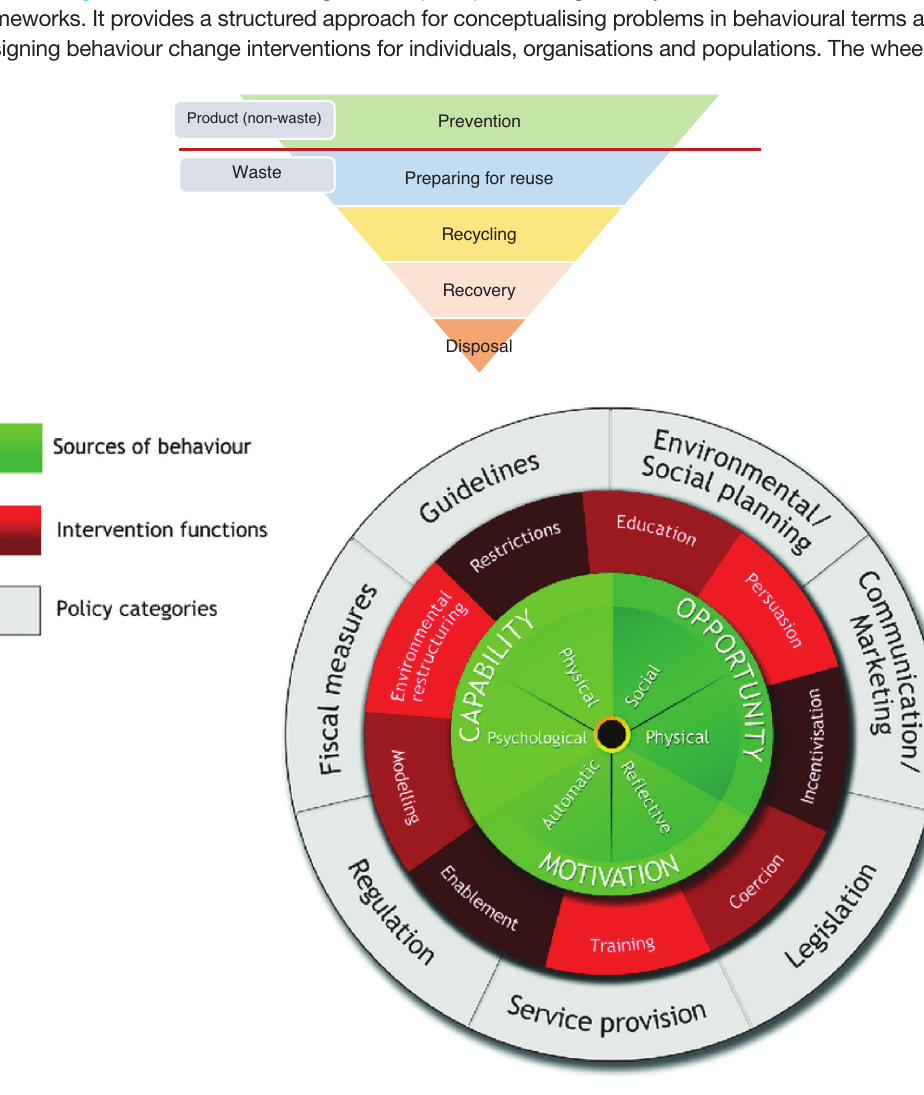
The BCW – a framework for intervention development, evaluation and evidence synthesis